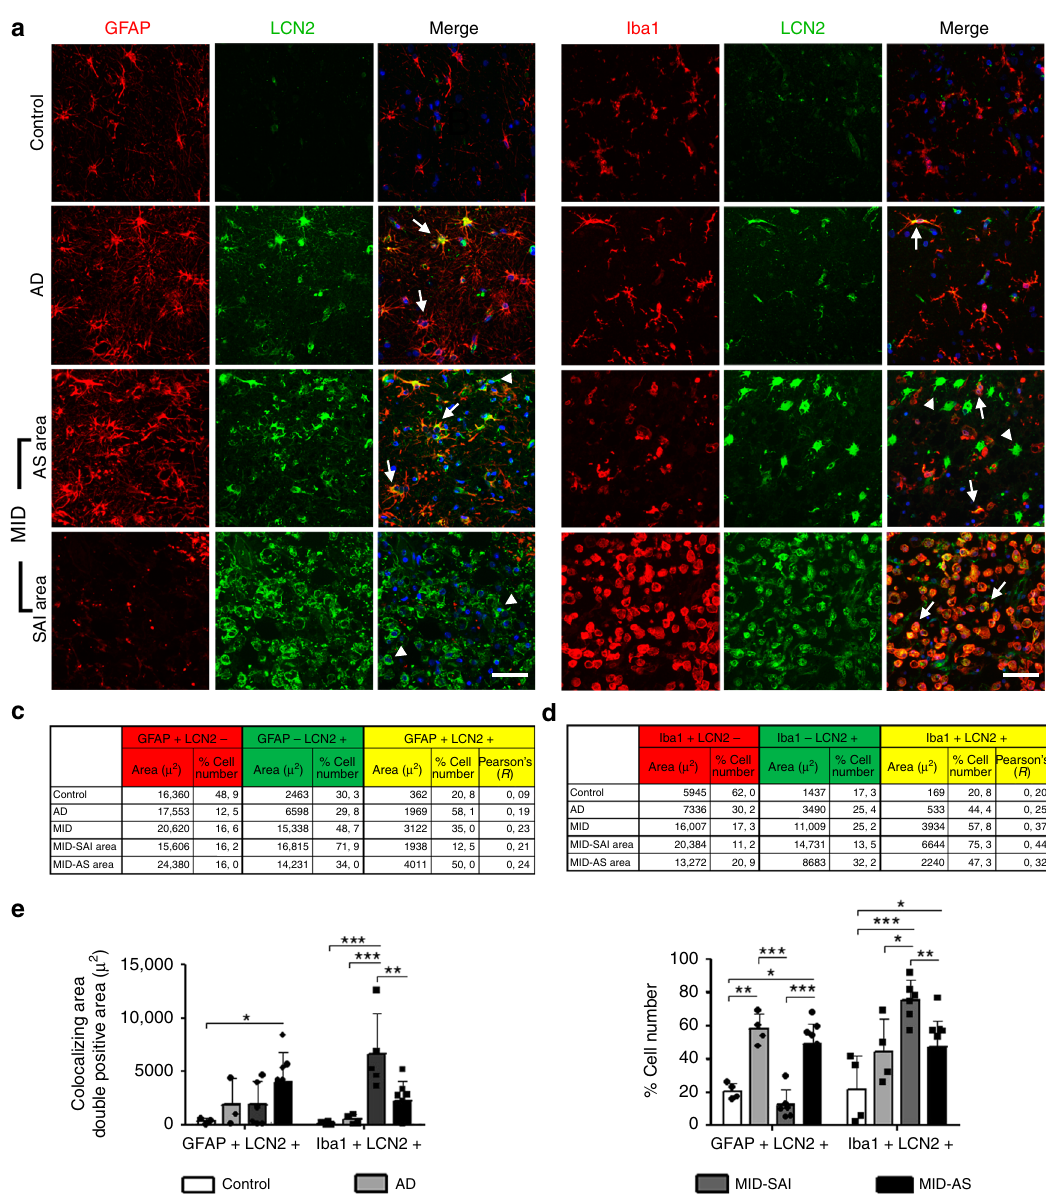
Fig. 5 LCN2 expression in brain tissue and association with glial markers. a LCN2 and GFAP double-immunostaining in the cerebral cortex of control, AD, and MID cases. LCN2 co-localises with GFAP immunoreactive astrocytes (arrows) in AD, with surrounding plaque like structures, and in MID in astrocytic scar area (MID-AS). Abundant LCN2 + GFAP- cells are observed in MID at the subacute infarction area (MID-SAI; arrow-heads), where there is little astrocyte presence. Bar = 50 µ m. b LCN2 and Iba1 double-immunostaining in the cerebral cortex of control, AD, and MID cases. LCN2 co-localises with Iba1 immunoreactive microglia in AD and MID-AS (middle panels, arrows). In MID-SAI, predominant Iba1 positive staining was observed, displaying almost entire colocalisation with LCN2 + cells (bottom panel, arrows). LCN2 + Iba1- cells are observed in MID-AS slices (arrow-heads). Bar = 50 µ m. c , d Quanti fi cation of ( c ) LCN2 and GFAP, and ( d ) LCN2 and Iba1 double-immunostainings. Tables show single- and double-stained area ( µ m 2 ), percentage of cells and Pearson ’ s colocalisation coef fi cient in Control, AD, and MID (total and divided in MID-SAI and MID-AS). e Graphic representation of double- stained area (left panel) and percentage of double-stained cells (right panel) in control, AD, MID-SAI, and MID-AS. Data are shown as mean ± SD of control ( n = 4), AD ( n = 4), and MID ( n = 10). MID-AS areas were quanti fi ed in 10 cases and MID-SAI areas in 6 cases. Mean± SD is included for